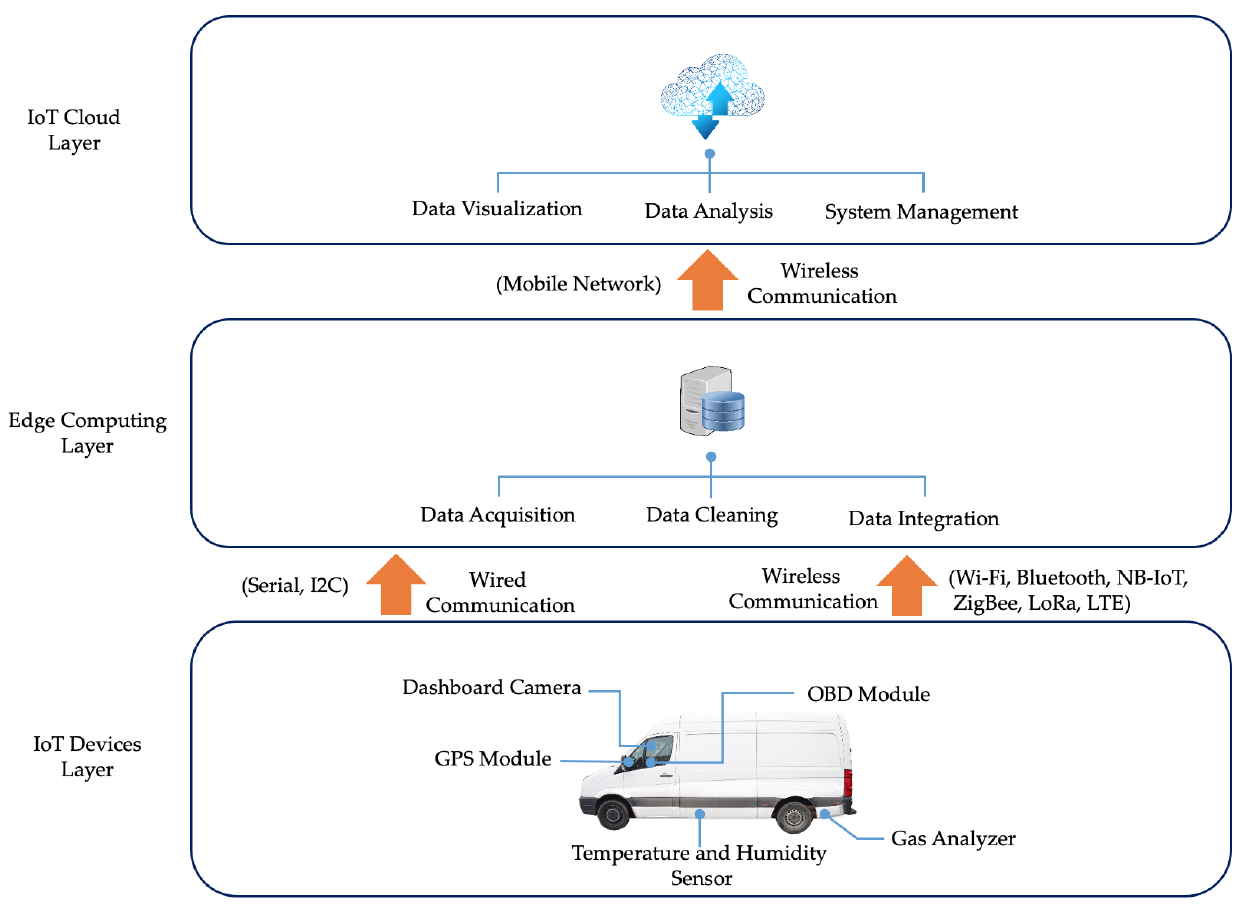
Figure 2. ParcEMon platform